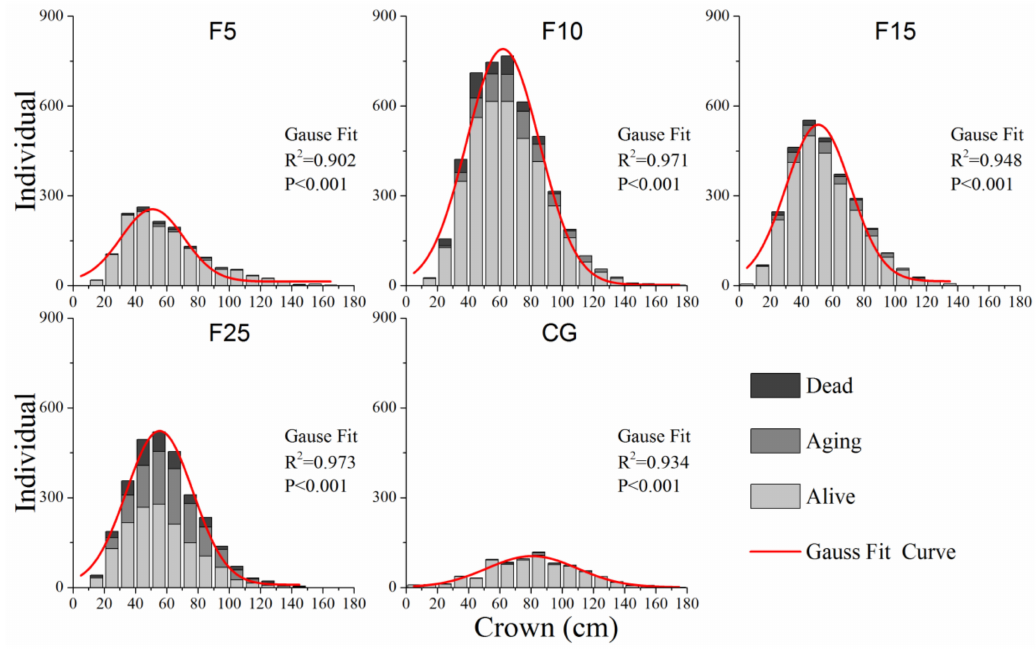
Figure 3. Crown distribution structure of alive, aging, and dead A. ordosica in F5 (enclosed 5 years), F10 (enclosed 10 years), F15 (enclosed 15 years), F25 (enclosed 25 years), and CG (continuously